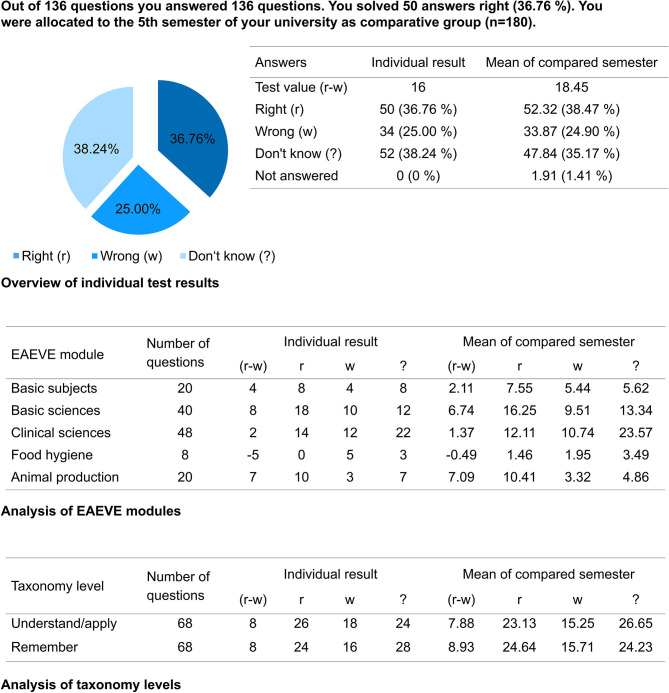
Individual total test result, exemplary presentation of a fifth-semester student; EAEVE, European Association of Establishments for Veterinary Education; r, right answer; w, wrong answer; ?, “don't know” option.